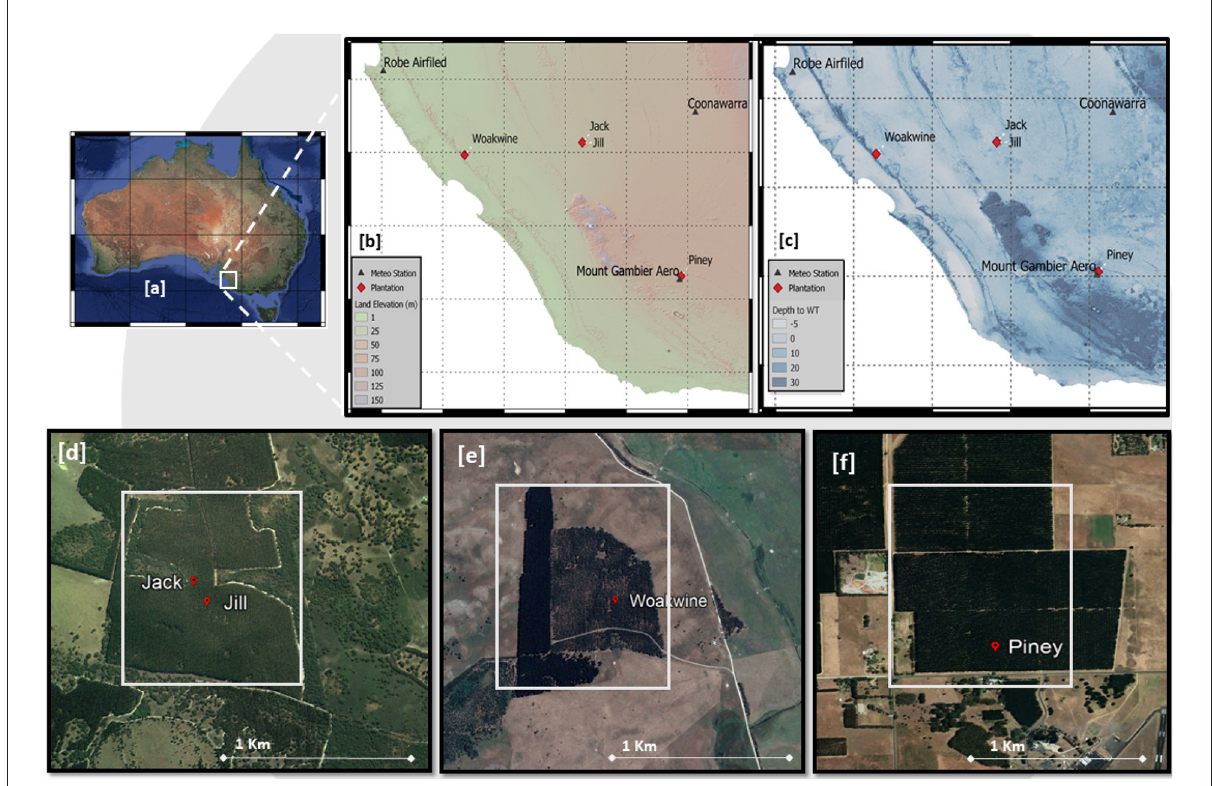
FIGURE1 Location of the study area within Australia (a) . Details of the topography, plantation sites, and meteorological stations used in this study (b) . Details of the depth to WT of the upper unconfined aquifer (c) . Satellite images of the four locations. Jack and Jill (d) , Woakwine (e) , and Piney (f) . The squares represent the model cell and the CMRSET averaging